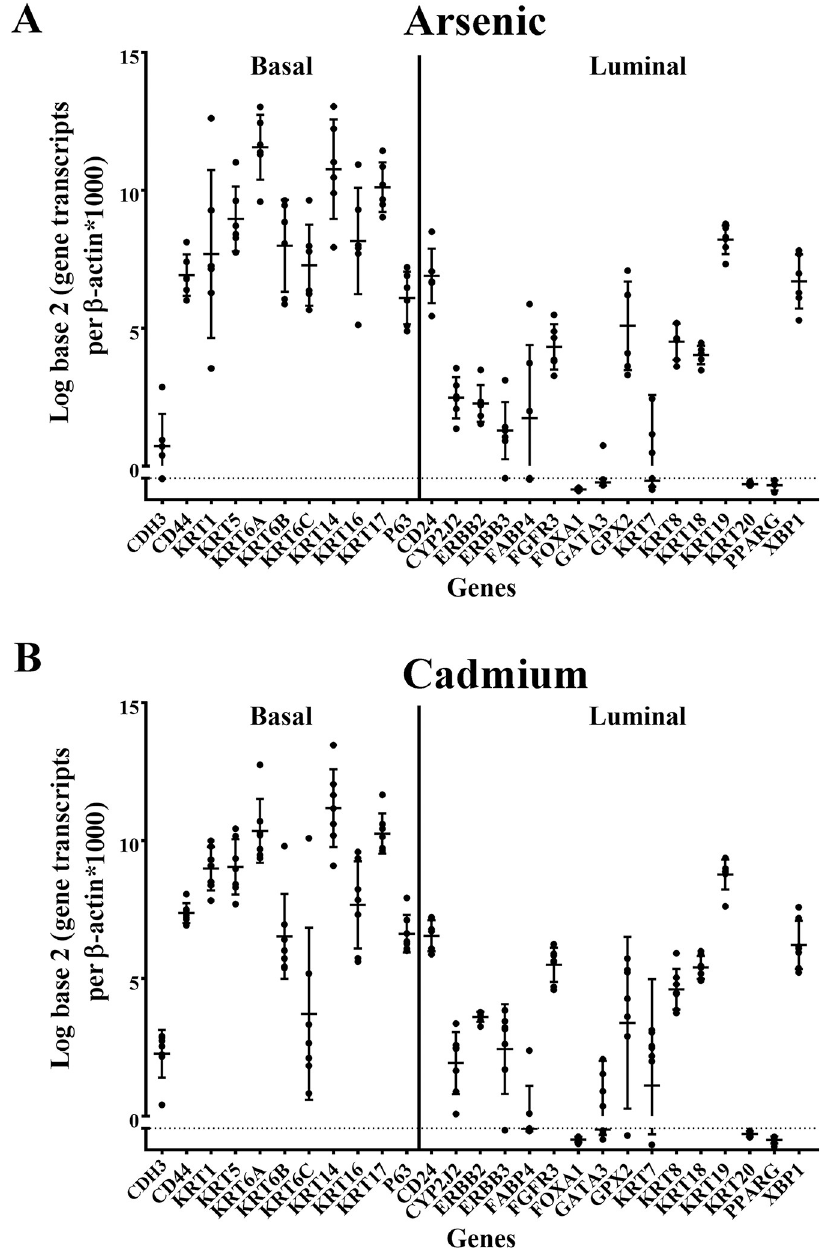
Fig 2. Gene expressionanalysisof basaland luminalmarkergenes intumors producedby As 3+ andCd 2+ -transformed cells. Real-timePCRanalysis of basal andluminal markersin As 3+ (A) andCd 2+ (B) tumor transplants. The analysiswas donein triplicates andis plottedas the mean ± SD. The data is plottedon a logbase 2scale pertranscript of β -actintimes 1000.